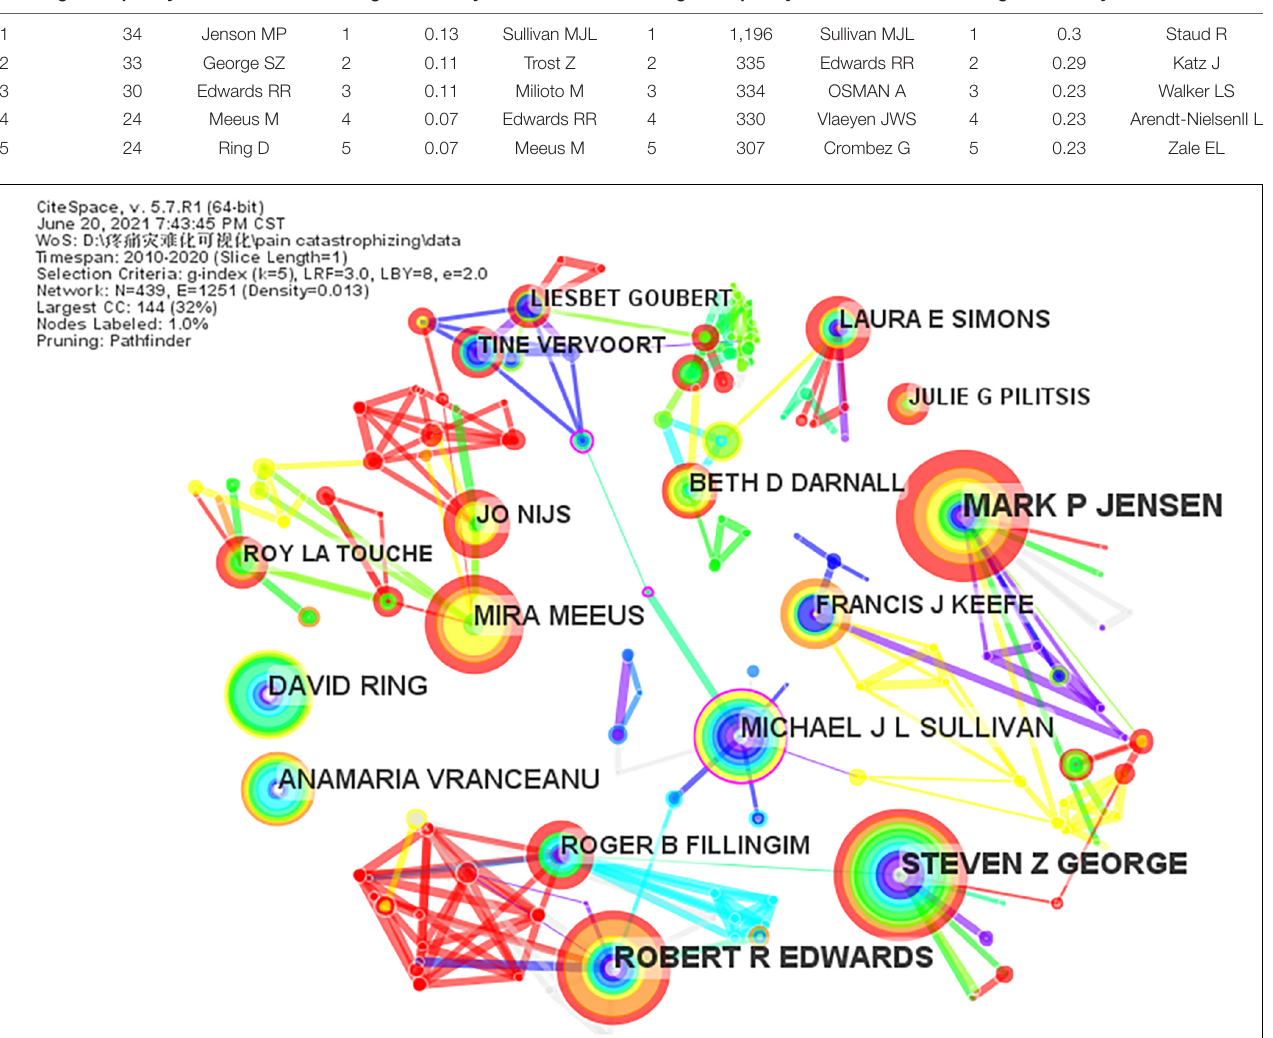
FIGURE 4 | A co-author map related to pain catastrophizing research from 2010 to 2020.